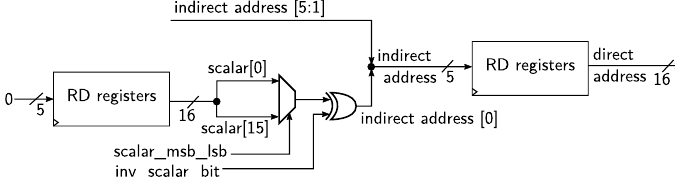
Figure 4: Description of how RD register 0 is used to make an indirect address from one bit and one extra